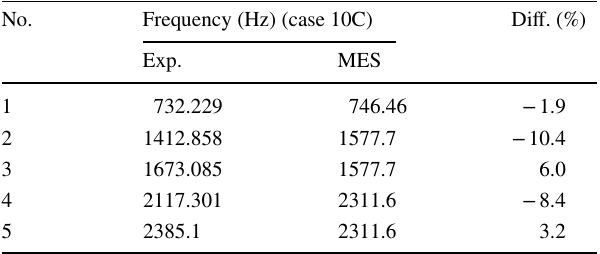
Table 6 The identified natural frequencies of the investigated rock bolt